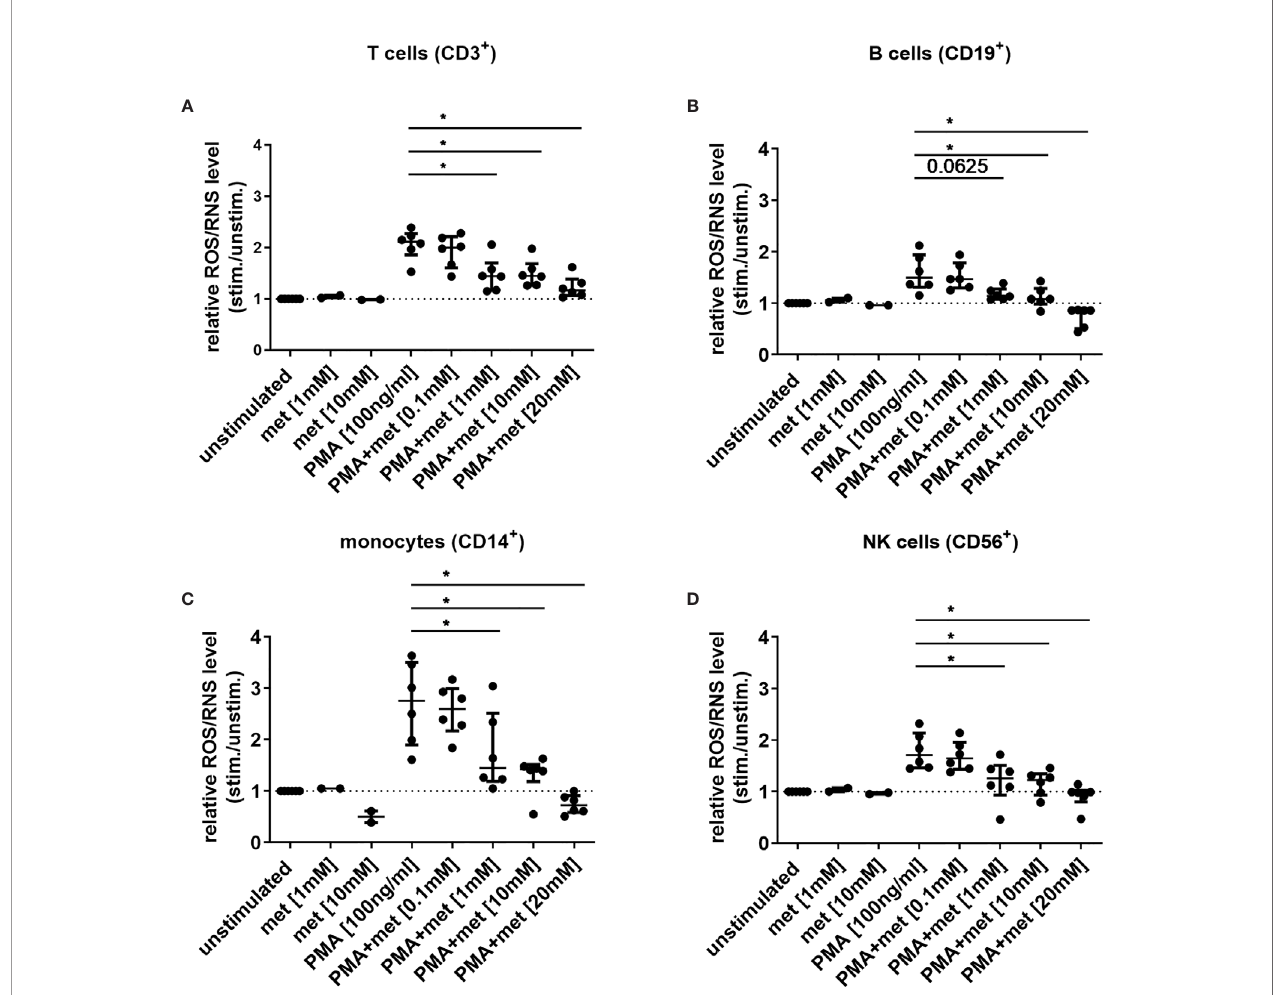
FIGURE 3 | Metformin reduces ROS/RNS level in human immune cells in a dose-dependent manner. (A – D) ROS/RNS level was measured in blood immune cells, cultured with metformin for 3 h (n=6; met alone n=2). Cells were either unstimulated or stimulated with PMA [100 ng/ml] for 10 min and ROS/RNS generation was measured by FC in (A) T cells, (B) B cells, (C) monocytes and (D) NK cells using DCFH-DA. Median with interquartile range is depicted and Wilcoxon test is used for statistical analysis. *P ≤